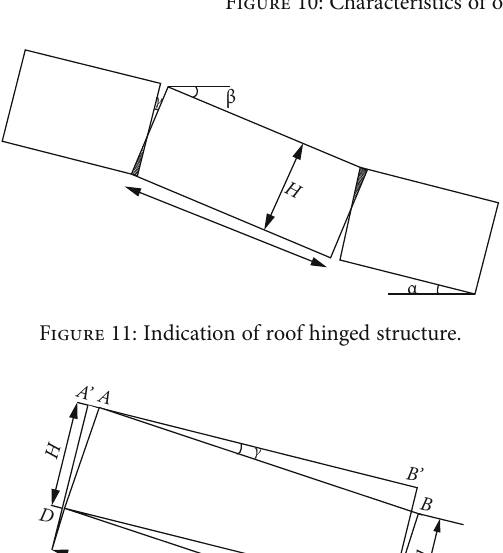
Figure 10: Characteristics of overlying strata in W1123 working face mining.